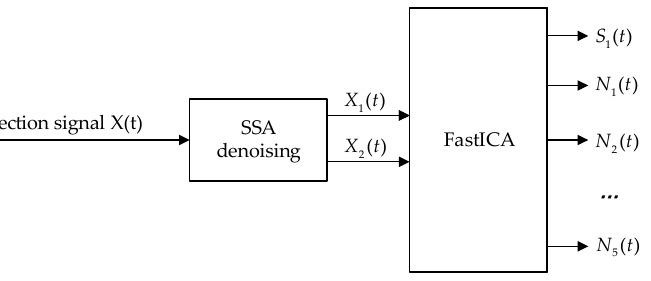
Figure 4. Flow chart of mixed signal separation process based on SSA and